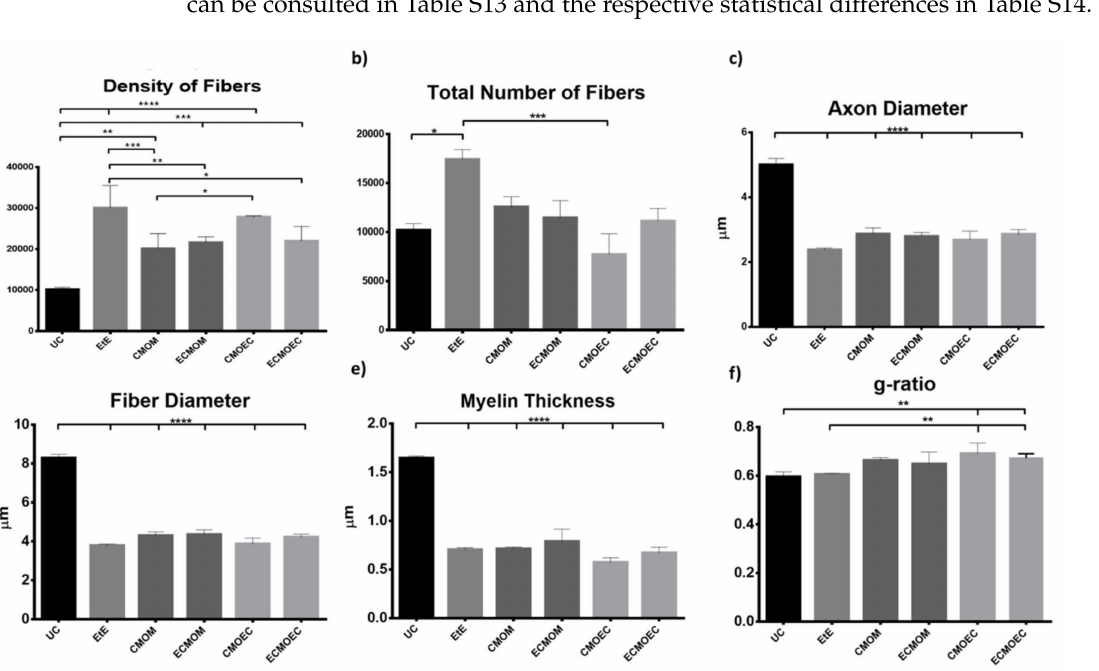
Figure 9. Results of the stereological assessment of sciatic nerve fibers 20 weeks after neurotmesis: ( a ) density of fibers; ( b ) total number of fibers; ( c ) axon diameter; ( d ) fiber diameter; ( e ) myelin thickness; ( f ) g-ratio (mean ± SEM)). * corresponds to 0.01 ≤ p < 0.05, ** to 0.001 ≤ p < 0.01, *** to 0.0001 ≤ p < 0.001, and **** to p <